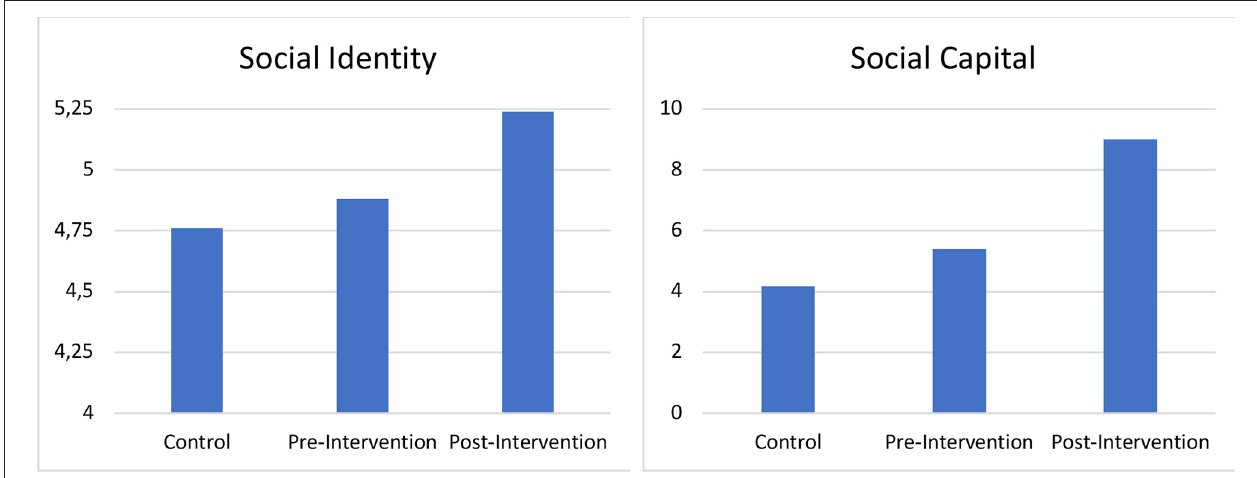
FIGURE 1 | Mean differences on social identity (left) and social capital (right) between control participants and intervention participants pre- and